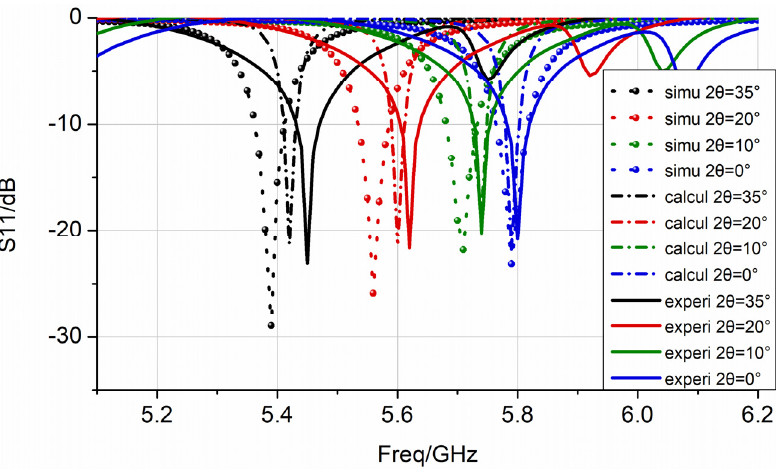
Figure 11. The full-wave simulation, theoretical calculation results, and experimental data, repre- sented by dotted, dashed, and solid lines, respectively. The S-parameters for bending angles of 0°, 10°, 20°, and 35° are represented by blue, green, red, and black lines, respectively.